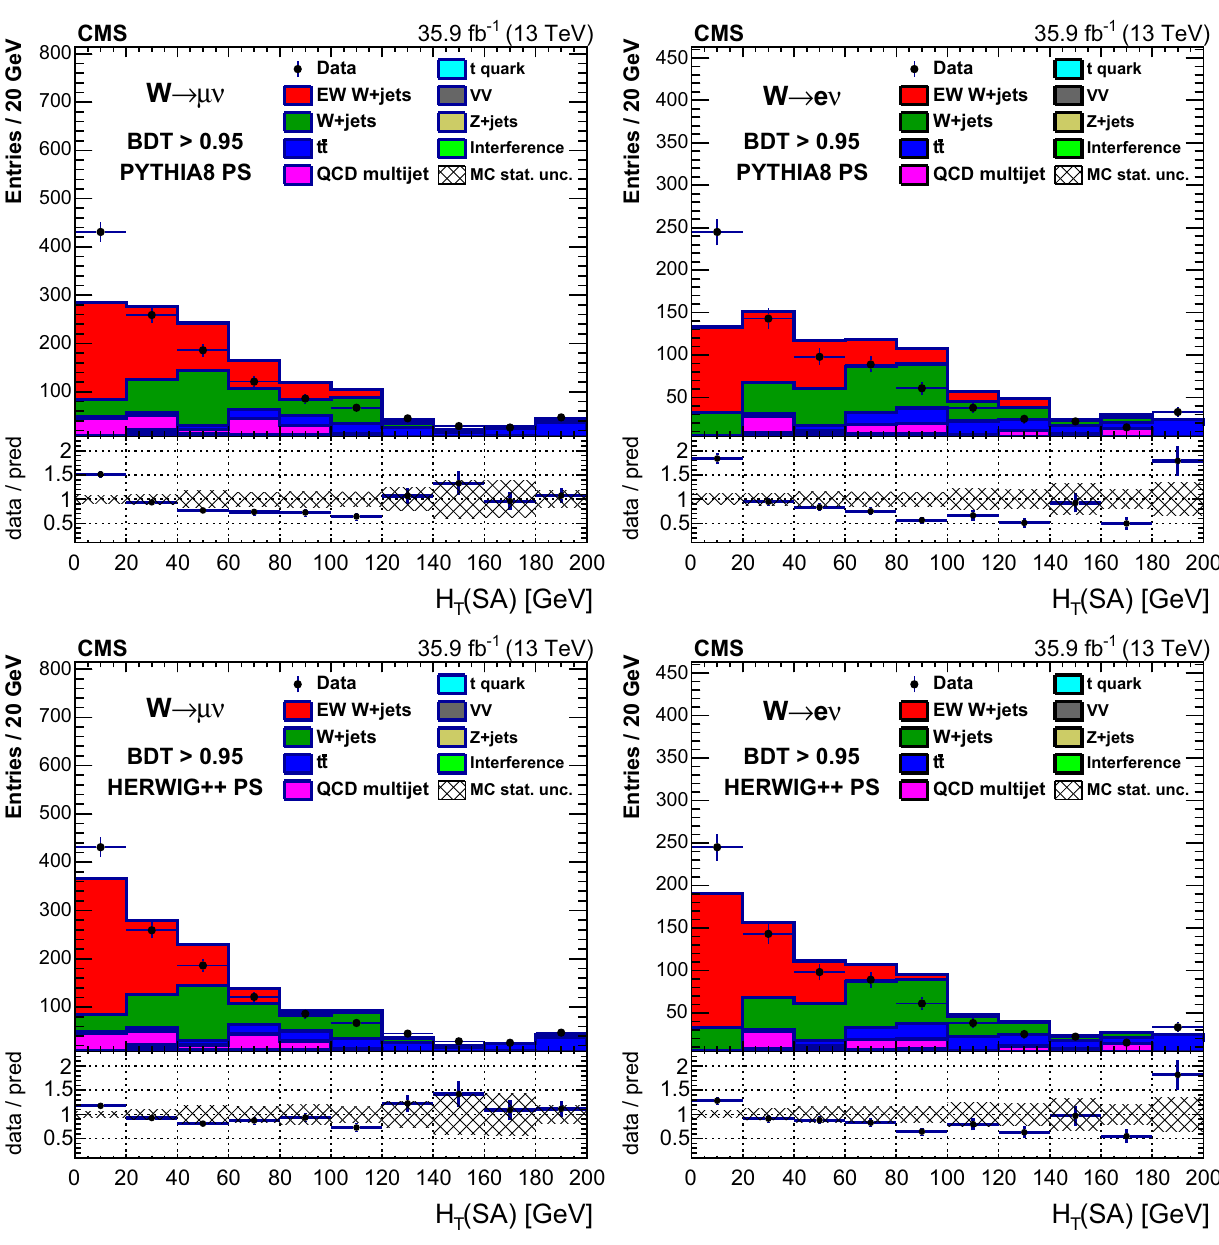
Fig. 18 Total soft activity (SA) jet H T for BDT > 0 . 95 in the muon (left) and electron (right) channels including the signal prediction from MadGraph 5_a mc@nlo interfaced with pythia parton showering (upper) and herwig++ parton showering (lower). In all plots the last bin contains overflow events A collection of “soft-track” jets is defined by clustering the selected tracks using the anti- k T clustering algorithm [51] with a distance parameter of R = 0 . 4. The use of track jets represents a clean and well-understood method [81] to reconstruct jets with energy as low as a few GeV.